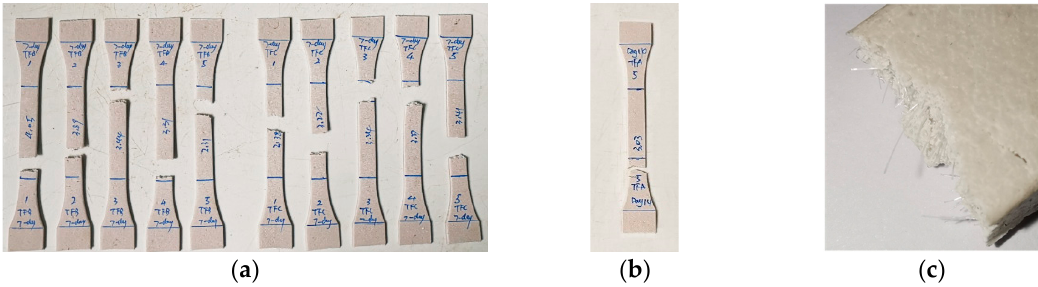
Figure 8. Specimens after rupture and the occurrence of fracture. ( a ) specimens ruptured in the gauge length, ( b ) a specimen ruptured out of the gauge length, ( c ) fracture surface of a fiber-containing specimen.